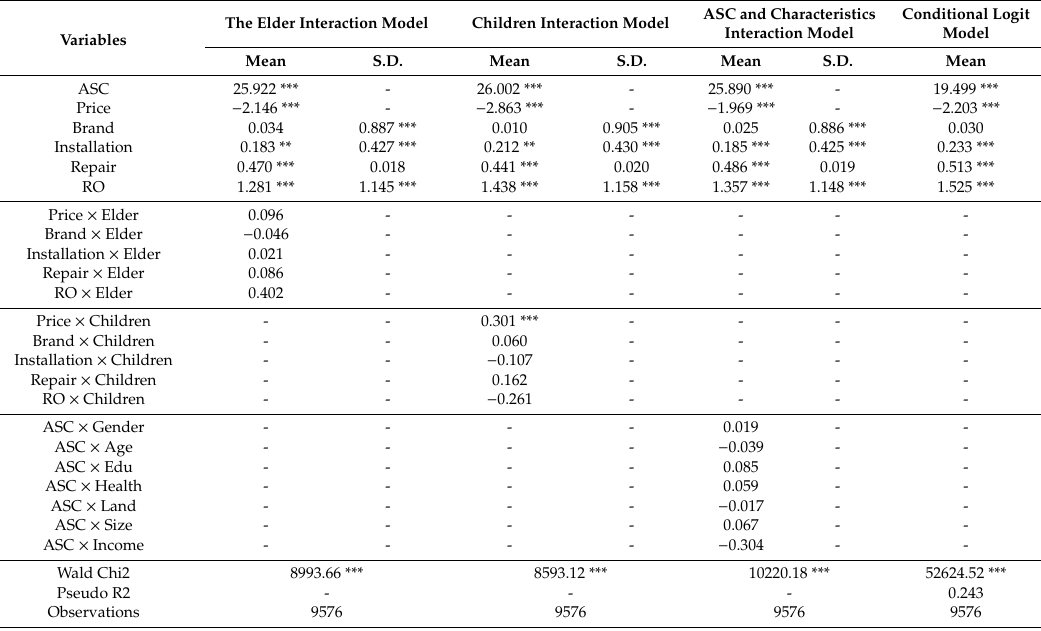
Table 10. The results of basic model on family and individual characteristics.